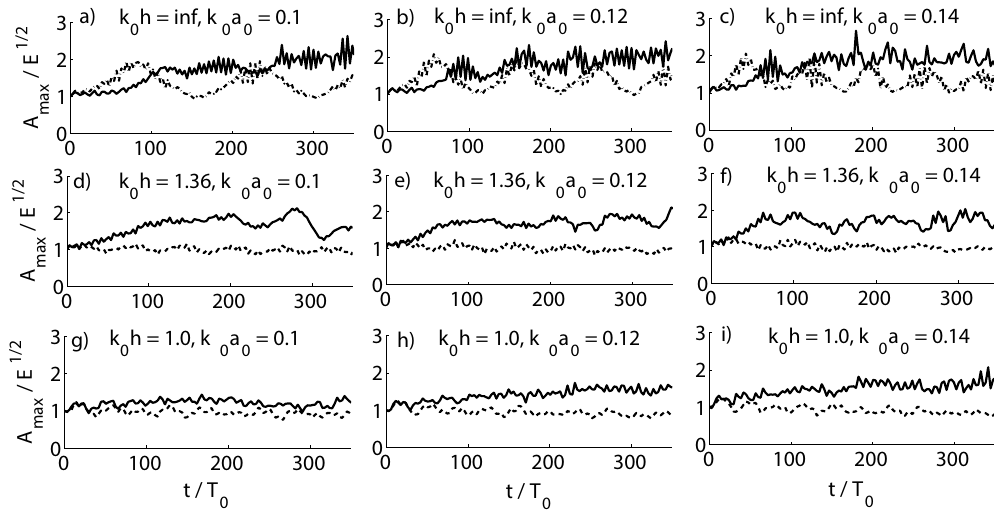
Fig. 3. Temporal evolution of the normalised maximum amplitude: plane wave seeded with collinear perturbations (dashed line); plane wave seeded with oblique perturbations (solid line). These results have been summarised in Figs. 4, 5 and 6. (I.e: the maximum value of normalised maximum amplitudes shown in (c) ( k 0 = ∞ and k 0 a 0 = 0 . 14), for oblique perturbations (solid line), corresponds to the given value of kh = inf in Fig. 6 for the oblique